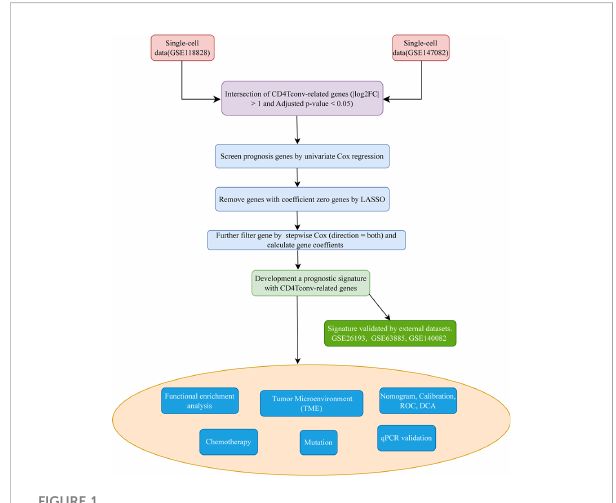
FIGURE 1 Work fl ow diagram. The speci fi c work fl ow graph of data analysis of the